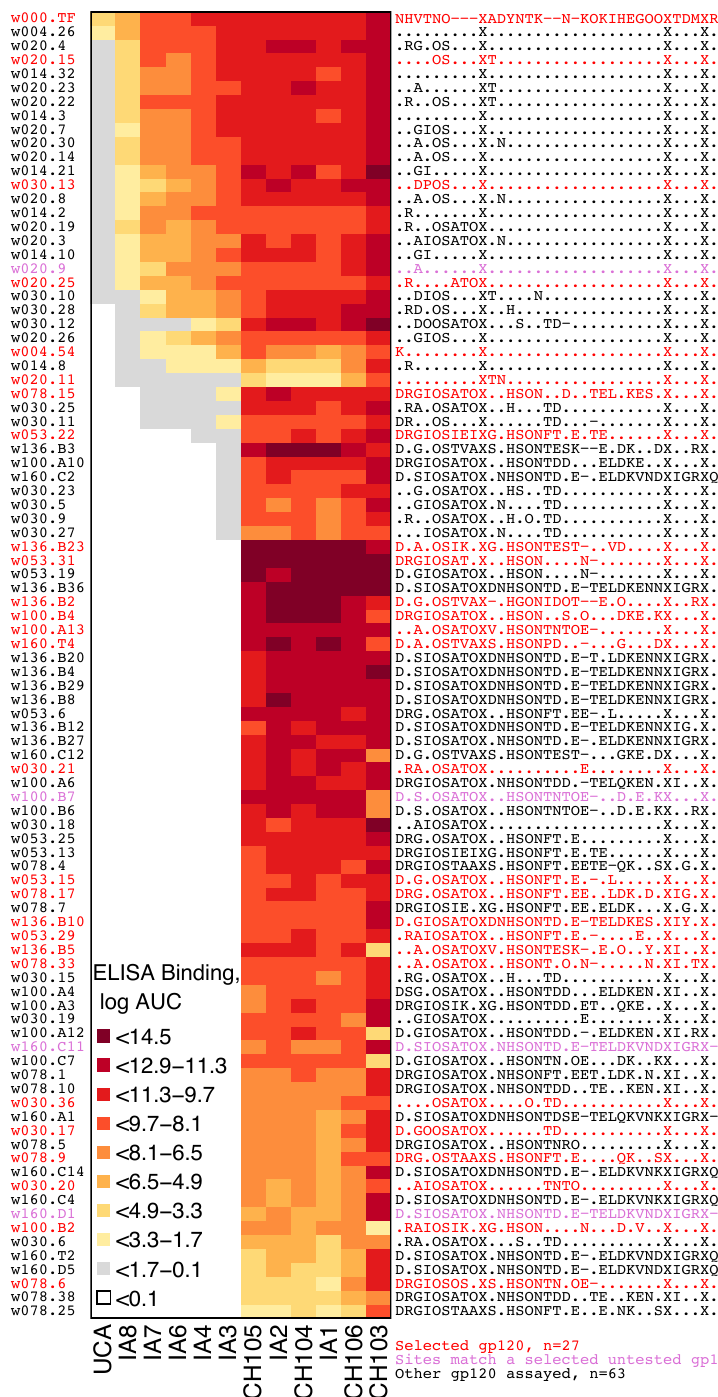
n=63w078.25w078.38w078.6w160.D5w160.T2 103 Selected gp120, n=27 Sites match a selected untested gp120, n=4 CH Other gp120 assayed, Figure 8. Selected Envs represent diverse binding phenotypes. Among the swarm of 54 Envs selected, 27 were synthesized as gp120s for ELISA binding assays (red text). Another four of the antigens tested contained selected sites that matched with those in selected Envs (purple text). Binding data are shown as colors to indicate log-transformed area under the curve (AUC) from dilution series, which summarized experimental results better than EC 50 s. Both assays tested Env constructs against monoclonal antibodies of the CH103 lineage, from mAb isolates (e.g., CH103) to the unmutated ancestor (UCA) via intermediate ancestors IA1–IA8 [15]. Blank entries indicate no binding was detected. Selected Env sites correspond to concatamers in Table S3. An “X” appears for gp41 sites, which were not in the gp120 antigens tested. Data are listed in Table